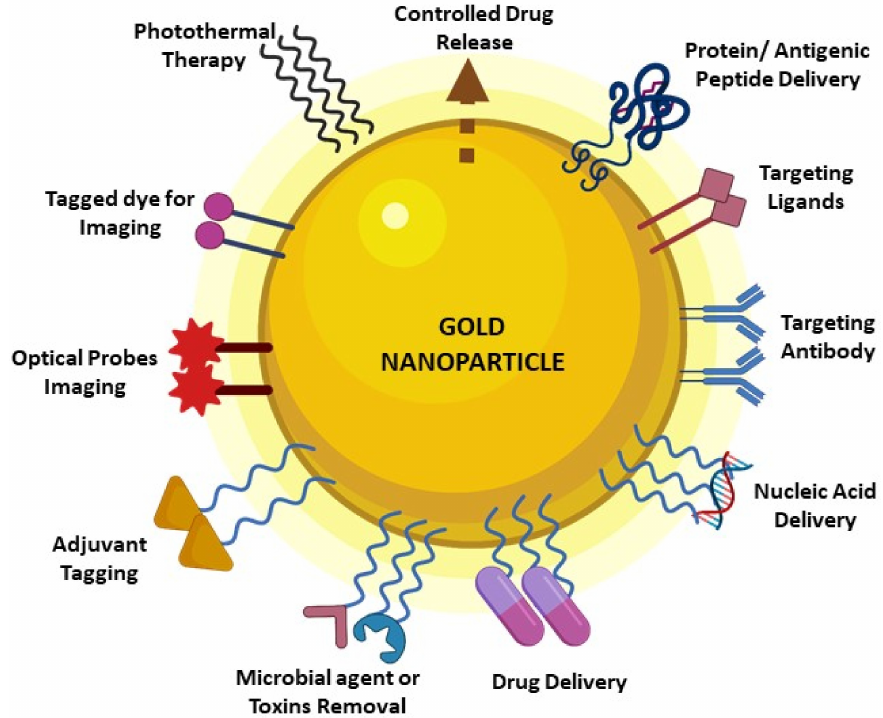
Figure 1. Schematic representation of the gold nanoparticle and its possible uses in the biomedical field. The gold nanoparticle can be tagged with one or more things depending on its intended use, such as the delivery of nucleic acids or protein fragments or the delivery of drugs and their controlled release. Targeting of its contents to the specific cells of the body is performed by using antibody- tagged GNPs or by the use of ligands attached to them targeting specific receptors of the